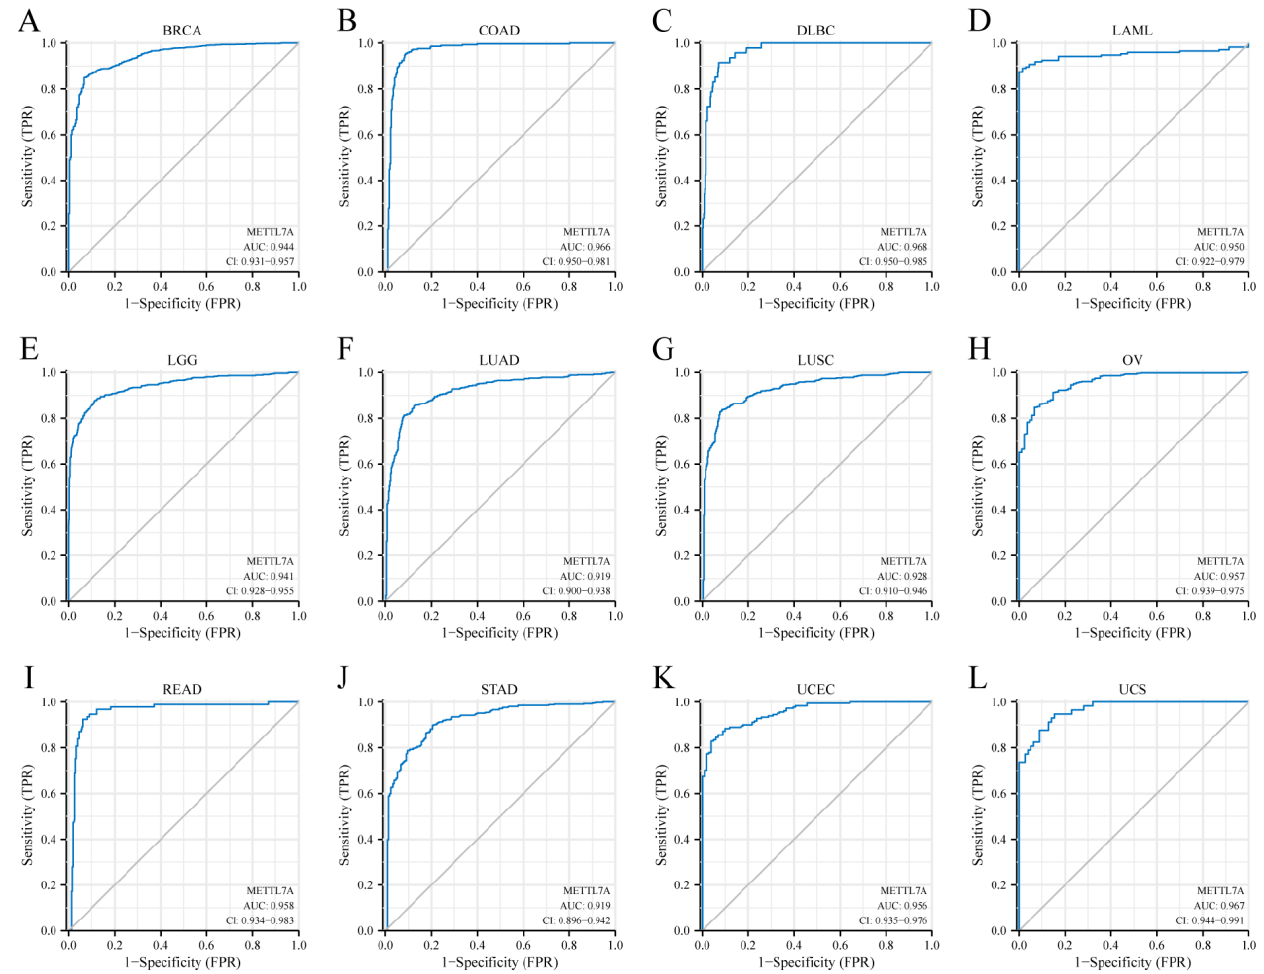
Figure 4. Receiver operating characteristic (ROC) curve for METTL7A expression in pan-cancer. ( A ) breast invasive carcinoma (BRCA); ( B ) colon adenocarcinoma (COAD); ( C ) lymphoid neoplasm diffuse large B-cell lymphoma (DLBC); ( D ) acute myeloid leukemia (LAML); ( E ) brain lower grade glioma (LGG); ( F ) lung adenocarcinoma (LUAD); ( G ) lung squamous cell carcinoma (LUSC); ( H ) ovarian serous cystadenocarcinoma (OV); ( I ) rectum adenocarcinoma (READ); ( J ) stomach adenocarcinoma (STAD); ( K ) uterine corpus endometrial carcinoma (UCEC); ( L ) uterine carcinosarcoma (UCS).